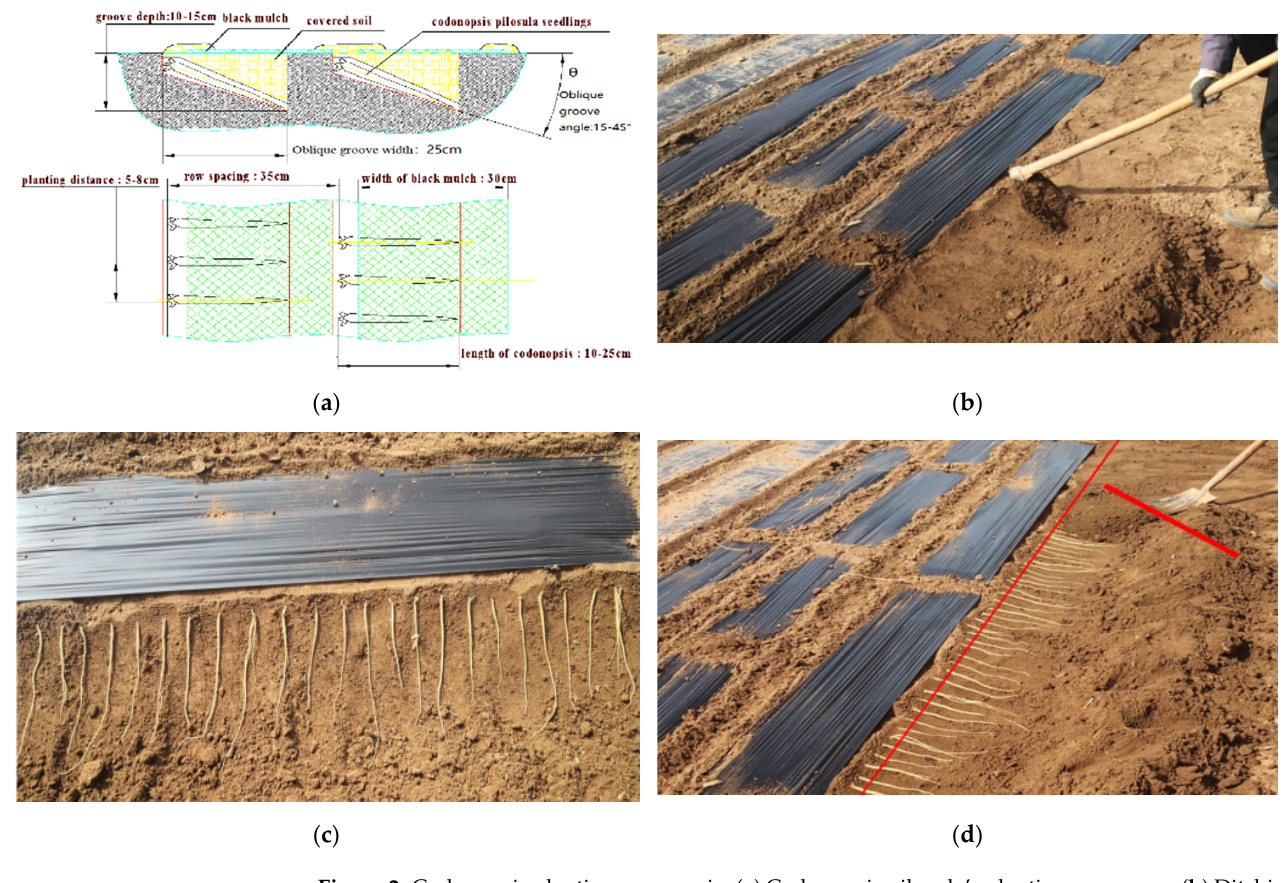
Figure 2. Codonopsis planting agronomic. ( a ) Codonopsis pilosula’s planting agronomy. ( b ) Ditching. ( c ) Codonopsis transplanting seedlings. ( d ) Soil and film covering.